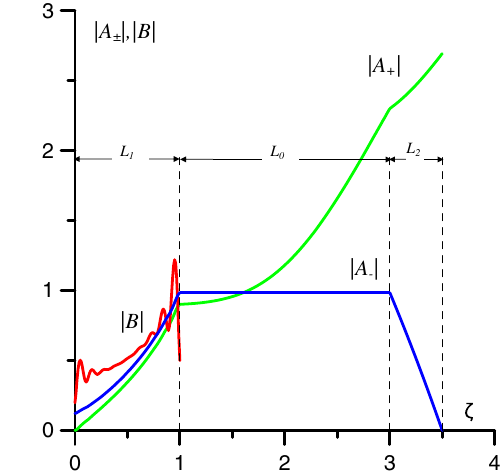
FIG. 5. (Color) Longitudinal profile of partial waves in the steady-state regime A þ (green line), A (cid:3) (blue line), and B (red line); L 1 ¼ 1 , L 0 ¼ 2 , L 2 ¼ 0 : 5 , ^ (cid:2) 1 ¼ 1 : 1 , ^ (cid:2) 2 ¼ 0 : 8 , (cid:4) ¼ (cid:3) 1 , and ^ (cid:3) ¼ 0 : 1